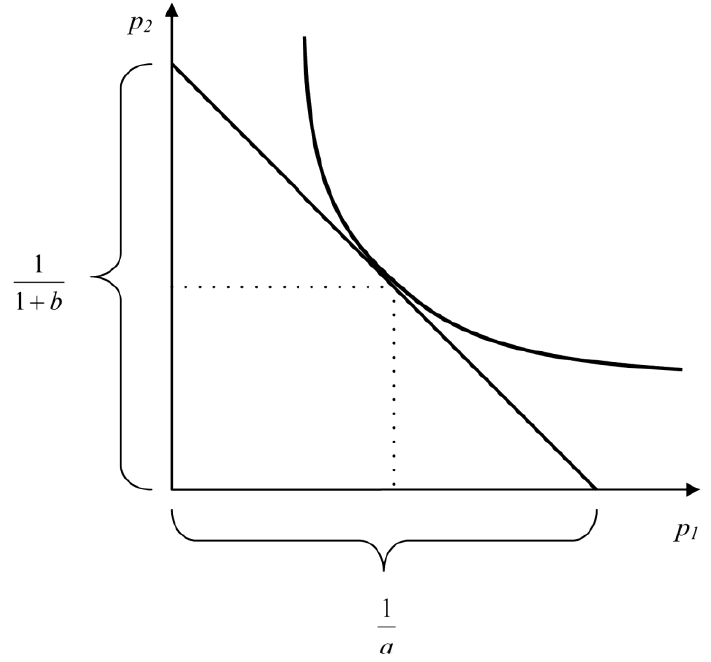
Figure 2. The relation between variables p 1 and p 2 within the feed consumption model.